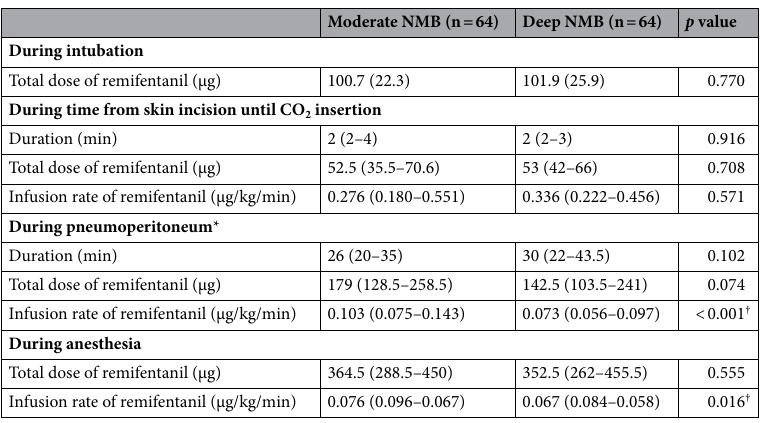
Table 3. Remifentanil doses. Values are presented as the mean ± standard deviation and the median (interquartile range). NMB, neuromuscular block; CO 2 , carbon dioxide. *defined as the time from CO 2 insertion until the removal of endoscopy. † p value < 0.05 between-group comparison.